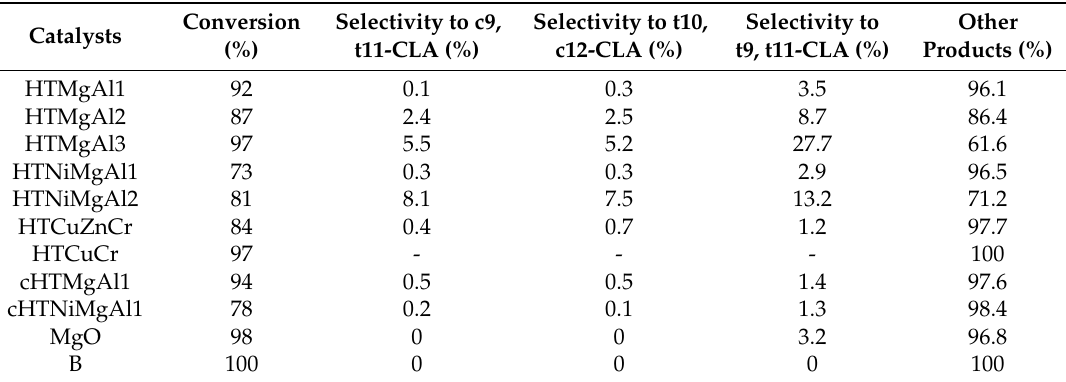
Table 3. Catalytic results for the isomerization of linoleic acid. 247